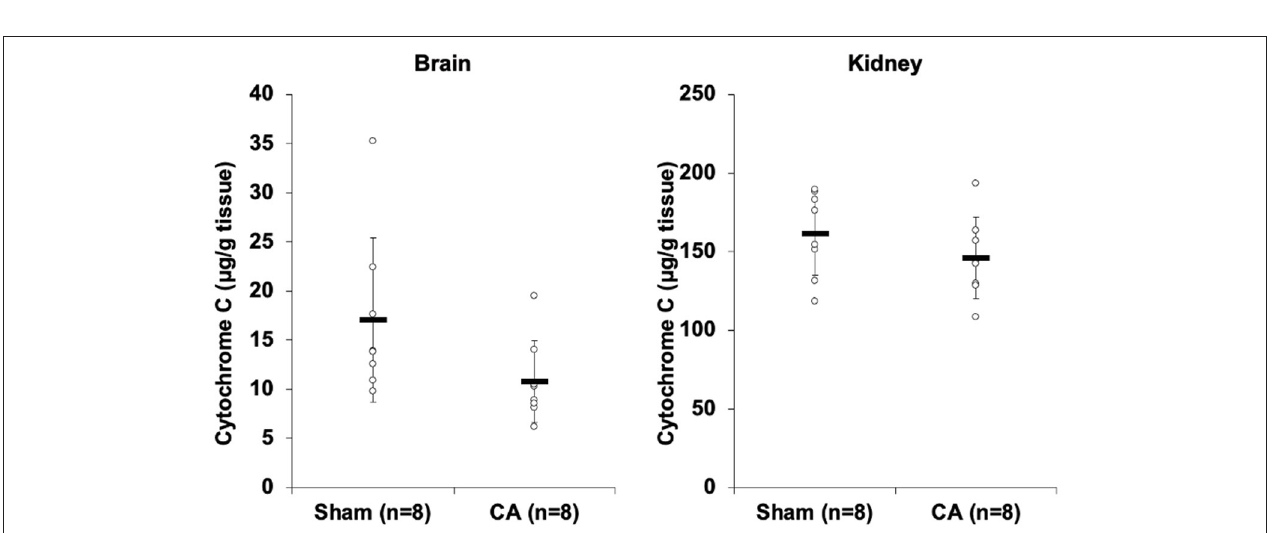
FIGURE 2 | Results of cytochrome C profiling ELISA comparing isolated mitochondria of cardiac arrest rats with that of sham rats. Cytochrome c concentration ( µ g/g tissue) of isolated mitochondria in the brain and the kidneys. Although there was no statistical difference, cytochrome c levels in the brain and kidney mitochondria of the CA group decreased compared to levels in the sham group (brain, 10.8 ± 4.2 and 17.0 ± 8.4 µ g/g tissue, p = 0.08; kidney, 146 ± 26 and 162 ± 27 µ g/g tissue, p = 0.25).